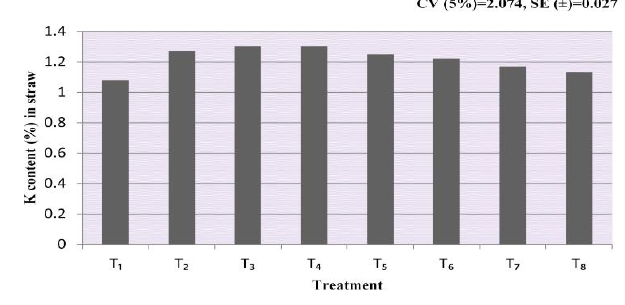
Figure 2: Potassium content (%) in rice straw of BRRI dhan49 as influenced by Banana leaves and chemical fertilizers.